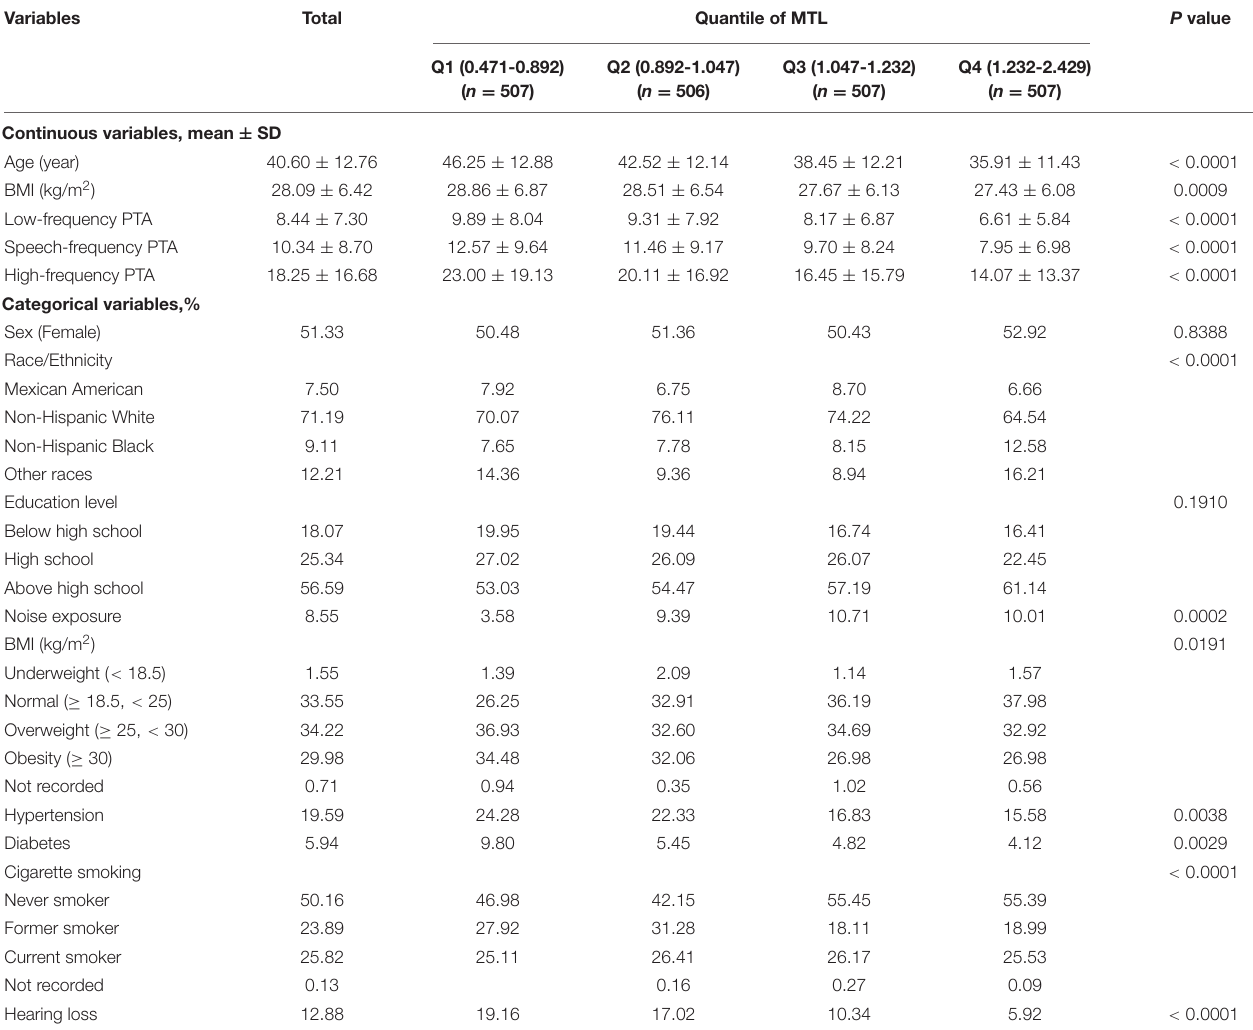
TABLE 1 | The weighted demographic characteristics of study